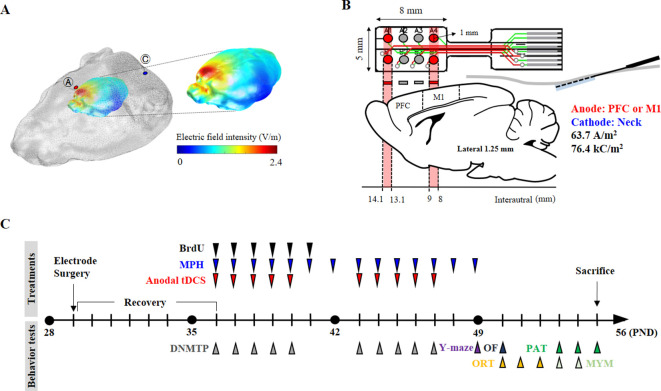
Experimental schematic diagram.(A) Three-dimensional tDCS simulation over the prefrontal cortex. The highest electric field intensity values are represented in red, and the lowest electric field intensity values are represented in blue. False color: electric field intensity (V/m). Ⓐ, anode electrode; Ⓒ, reference electrode. Anodal stimulation was delivered at an intensity of 63.7 A/m2 over the prefrontal cortex. The predicted peak electric field intensity was 2.4 V/m in the frontal cortex. (B) Schematic diagram showing each electrode position and corresponding cerebral cortical region. The anodal stimulation was pointed over the frontal cortex and the primary motor cortex via the electrode, and the cathode was positioned on the skin of the neck. (C) The time schedule of HD-tDCS or MPH treatment and behavior tests. OF, open-field test; PAT, passive avoidance test; MYM, modified version of the Y-maze test.